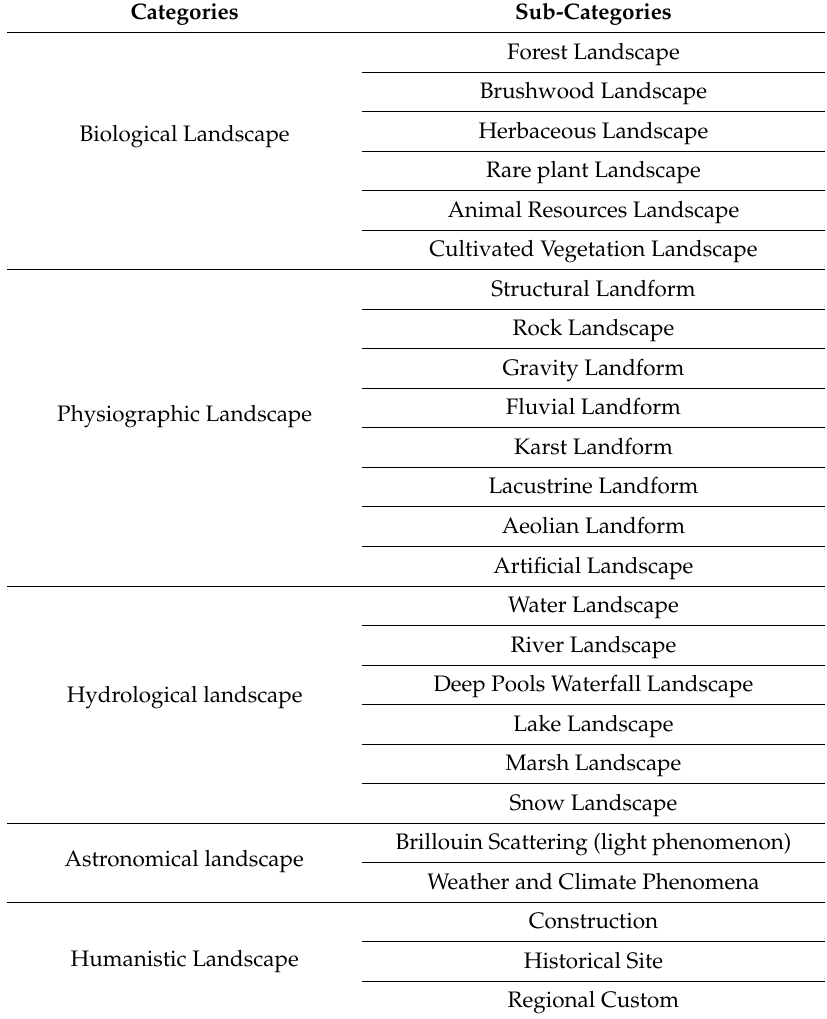
Table 1. Classification of Forest Landscape Resources (Information acquired from the